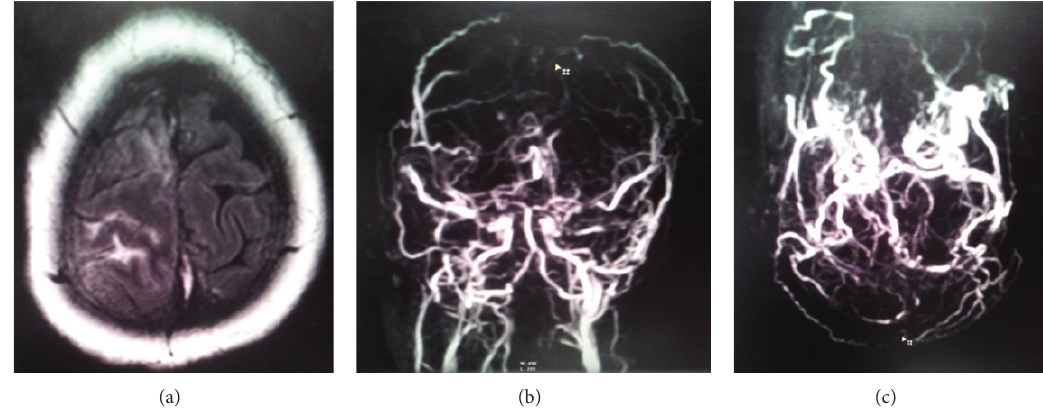
Figure 2: Brain MRI and magnetic resonance (MR) venography (AP view). (a) Hemorrhagic infarction was noted in the right parietal lobe on T2-weighed imaging. (b), (c) MR venography showed occlusion of the superior and inferior sagittal sinuses, both transverse sinuses, and bilateral sigmoid